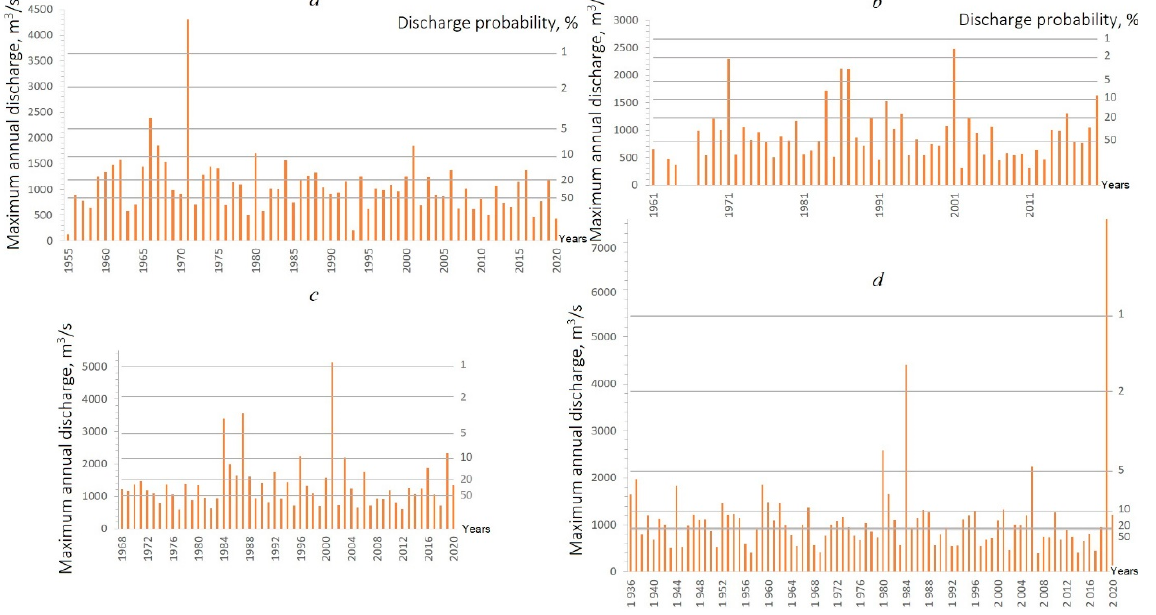
Figure 3. The observed maximum annual water discharges and the values of their standard probabilities calculated according to thePearson curve (type III) with parameter assessment using the method of moments: ( a )—Irkut–Tibelti, ( b )—Kitoi–Dabady, ( c )—Belaya–Mishelevka, ( d )—Iya–Tulun.